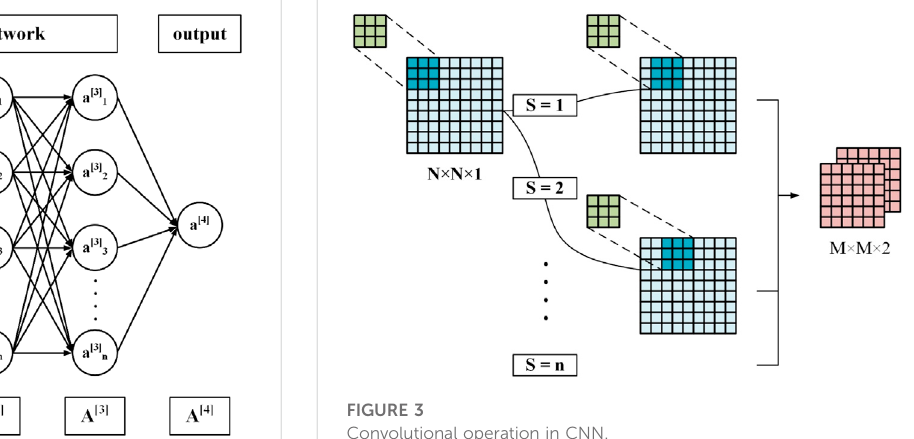
FIGURE 3 Convolutional operation in CNN.